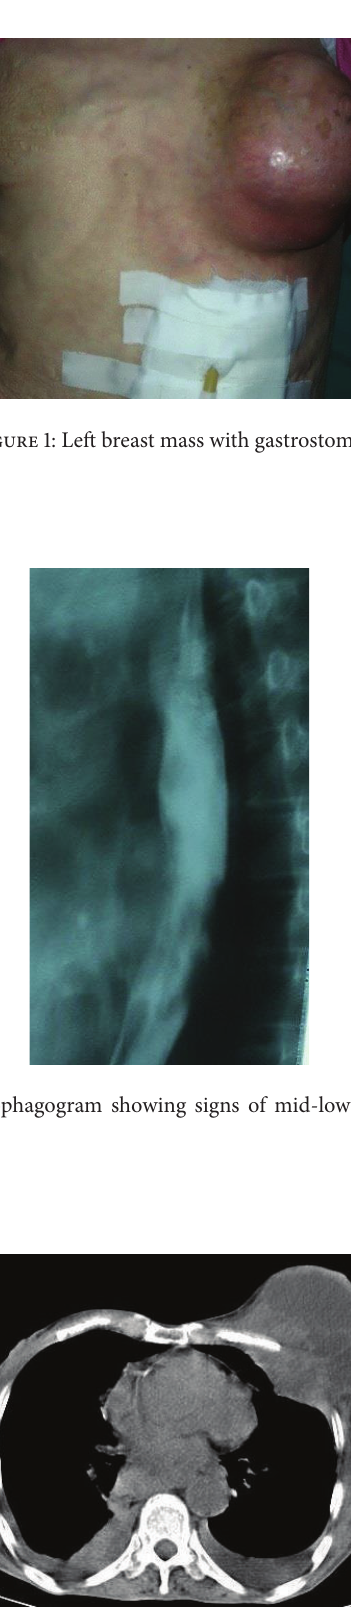
Figure 3: Oral and intravenous contrast-enhanced CT scan of the chest revealed bilateral pleural effusions with breast mass involving the left chest muscles and pleura destroying the rips.